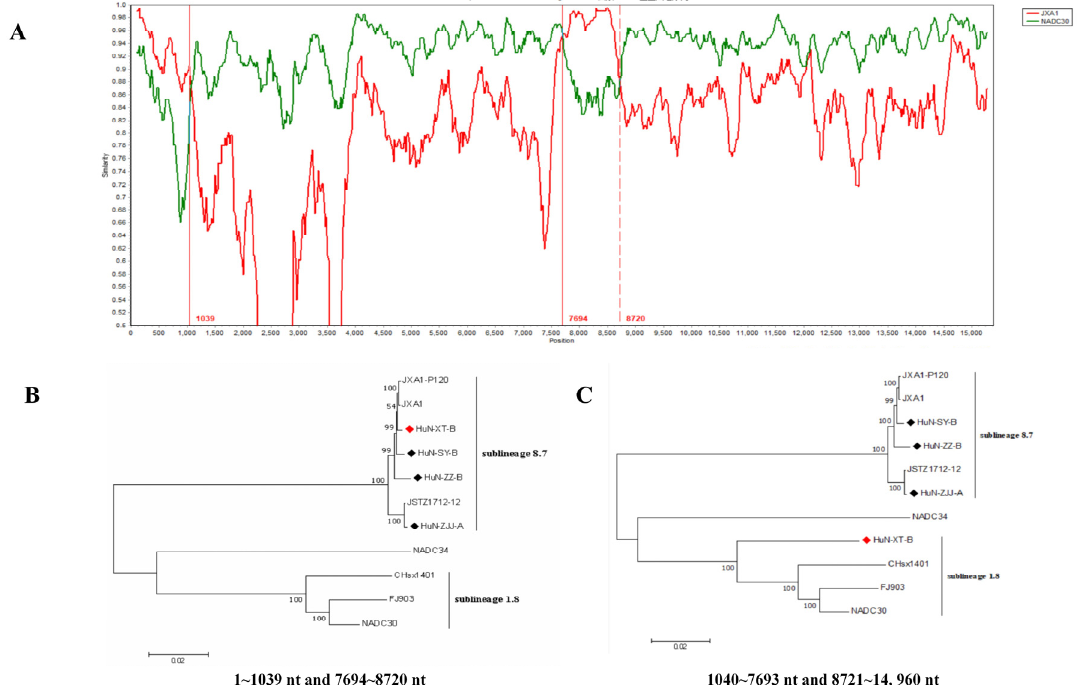
Figure 2. Genome-wide recombinant analysis of PRRSV strain HuN-XT-B predicted by the SimPlot v3.5 software. ( A ) the potential recombination breakpoints of HuN-XT-B were shown as red lines, compared with the parental PRRSV strains (NADC30 and JXA1). ( B ) Phylogenetic tree based on the nucleotide recombination regions (1–1039 nt and 7694–8720 nt). ( C ) Phylogenetic tree based on the nucleotide recombination regions (1040–7693 nt and 8721–14,960 nt). Red prism represented the recombinant PRRSV isolate, black prisms represented the other PRRSV strains isolated in the present study.